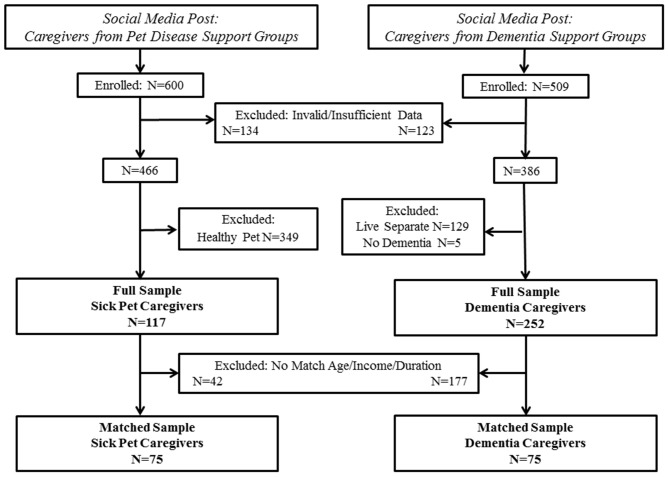
Inclusion and Enrollment.